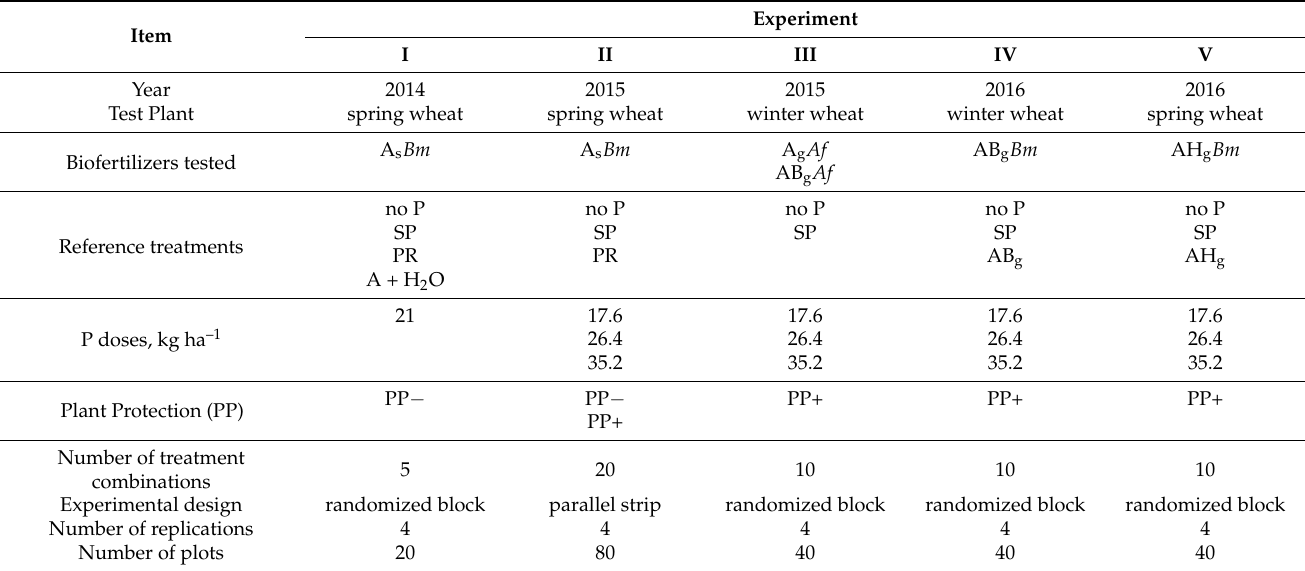
Table 2. Field experiments conducted—trial